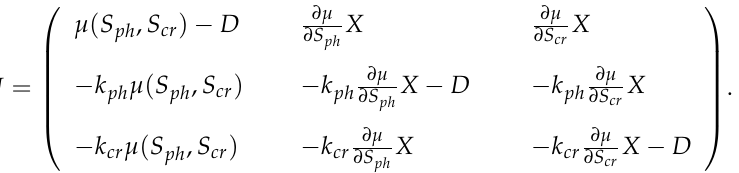
Figure 2. ( Left ): the equilibrium components S dot&solid line passes trough S 0 on D . The horizontal dash-dot&solid line passes trough 0. On the horizontal axis (left and right plot), the solid circle denotes ( 1 ) D cr , the solid box denotes D